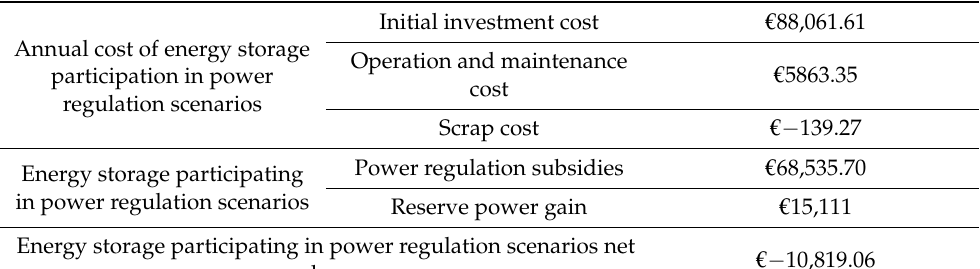
Figure 10. Frequency deviation contrast. Table 7. Annual costs and benefits of energy storage participation in power regulation